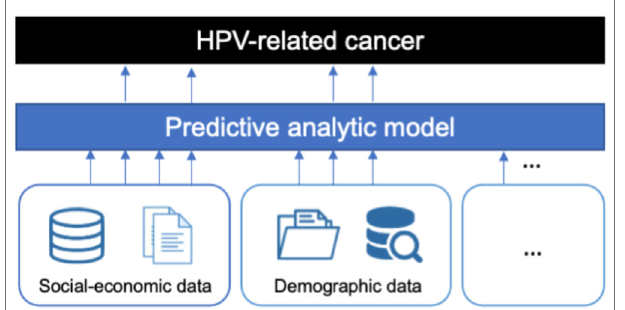
FIGURE 1 | The proposed framework. Predictive analytics model incorporates the indicators from heterogeneous data sources as features and then fi lters the most important indicators to explain the pattern of HPV-related cancer infection.